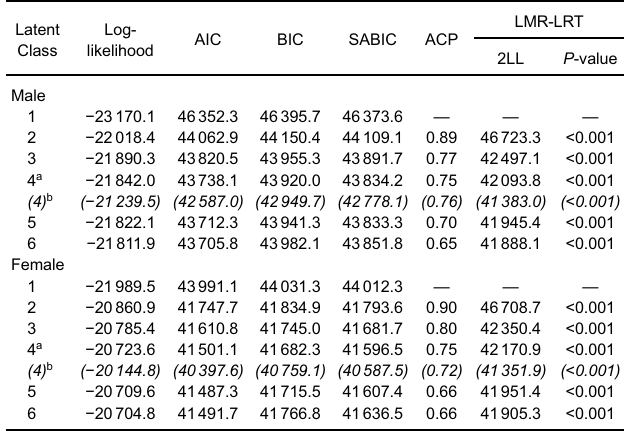
Table 2. Determining the number of latent subgroups using the unconditional